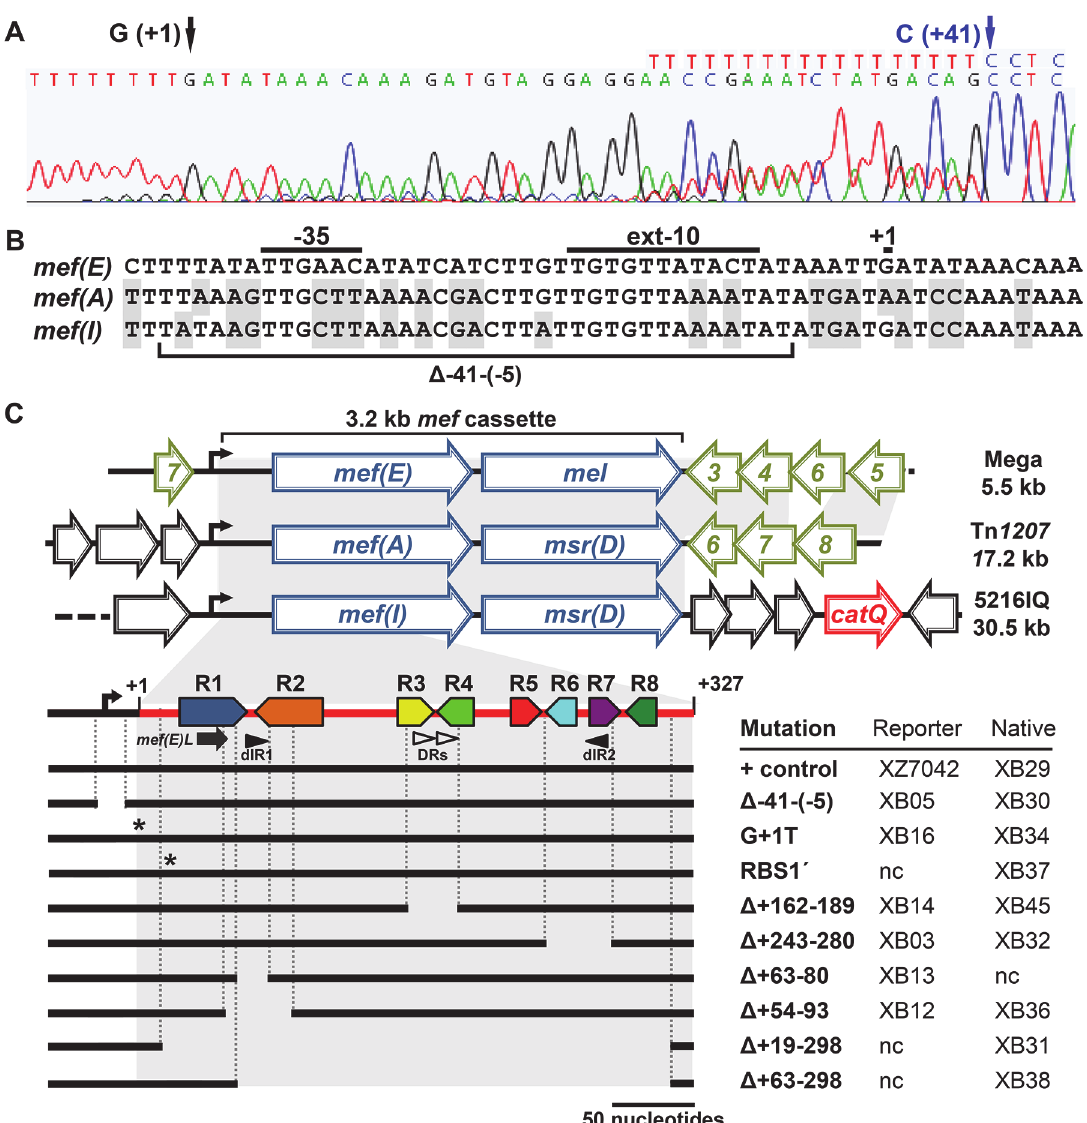
Fig 1. Identification of the promoter for the mef(E)/mel ( msr(D)) operon . a) Identification of the operon transcriptional start site in the chromatogram of the nucleotide sequence of 5 ’ RACE PCR products. Poly-thymine runs indicate the 5 ’ end of a transcript molecule. Numbered arrows indicate the predicted 5 ’ termini. b) Comparison of the predicted mef(E)/mel promoter sequence with putative promoters of other mef -containing elements mef (A) and mef (I) found in S . pneumoniae . The extended-10 and the-35 promoter sequences are underlined and labeled. The deleted sequence ( Δ -41-(-5) of mutations in the native mef(E) locus (XB30) or the mef(E) - lacZ r eporter locus (XB05) is indicated; ‘ +1 ’ indicates the transcriptional start site. Shading indicates dissimilar nucleotides compared to the mef(E) promoter region. c) The top panel illustrates the genetic organization of mef -containing elements in S . pneumoniae . The homology of the 3.2 “ mef cassette ” was extensive from RBS1 through mel(msr(D)) as indicated by shading. Blue arrows, macrolide resistance genes; red arrow, chloramphenicol resistance gene cat Q; green open arrows, transposon-related genes; open arrows, unrelated genes. The bottom panel illustrates the series of mutations generated in the 5 ’ regulatory region of the native mef(E)/mel locus of GA17457 and the reporter locus, a mef(E)-lacZ fusion inserted into bgaA in XZ7042. The annotated red line represents the 327 base 5 ’ mef(E)/mel regulatory mRNA region with the mef(E)/mel promoter shown as a bent arrow. Each pair of converging, colored solid arrows represents one of four pairs of inverted repeats. Black arrow, mef(E)L . closed arrow heads, distal 17 base inverted repeats (dIR1 and dIR2);open arrow heads indicate 12 base direct repeats (DRs). The descriptive name of each mutation and the resulting native-locus and reporter mutant designations are indicated in the right-hand columns; nc, not created.